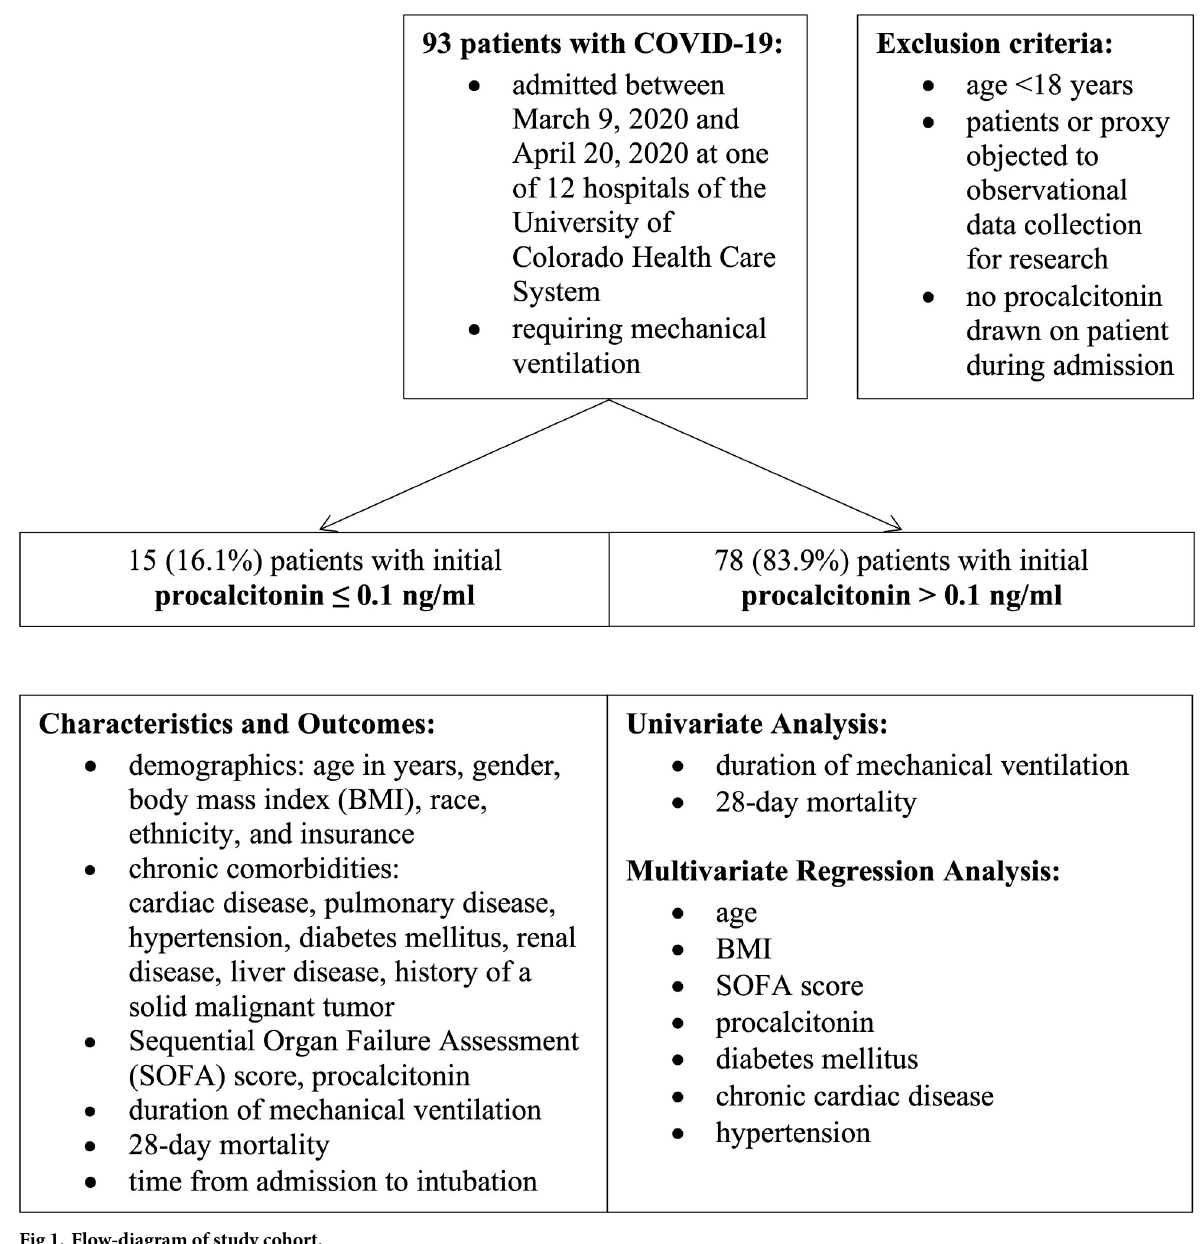
Fig 1. Flow-diagram of study